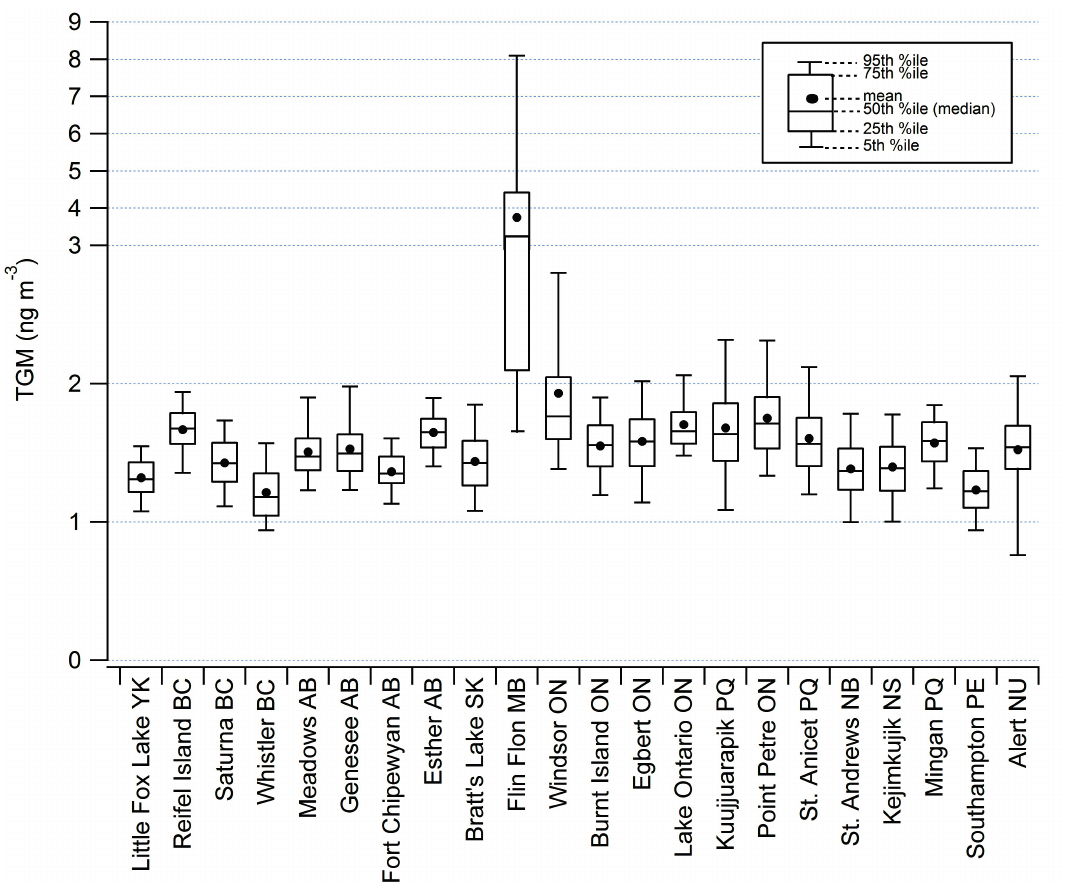
Figure 2. A comparison of total gaseous mercury (TGM) measurements, west to